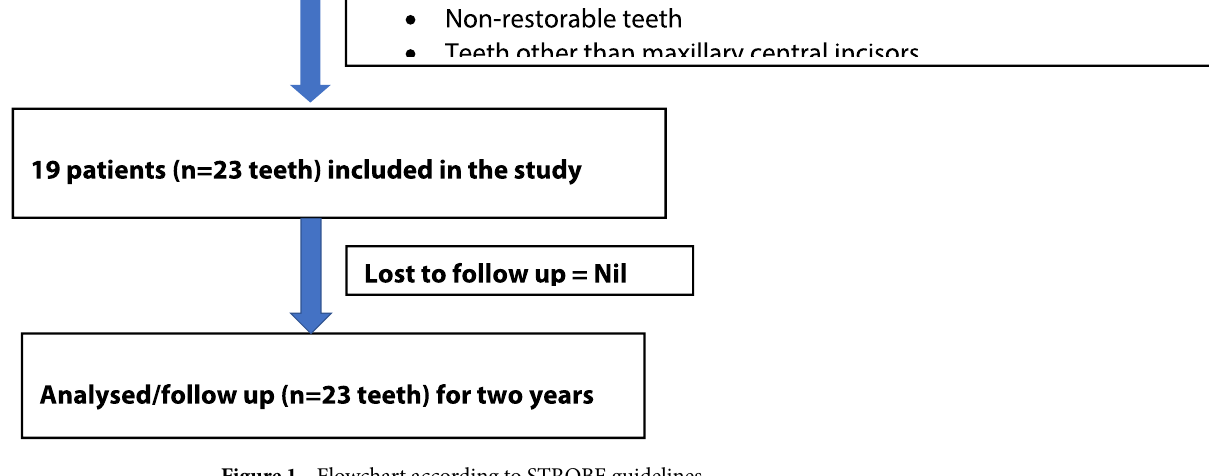
Figure 1. Flowchart according to STROBE